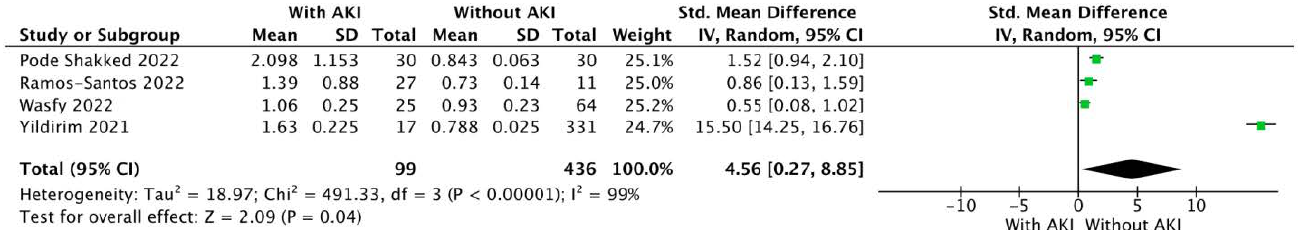
Figure 4. Forest plot of Cystatin C levels among Patients with COVID-19 with and without acute kidney injury (AKI). The center of each square represents the standard mean differences for individual trials, and the corresponding horizontal line stands for a 95% confidence interval. The diamonds represent pooled results. Legend: AKI: acute kidney injury; CI: confidence interval; SD: standard deviation.